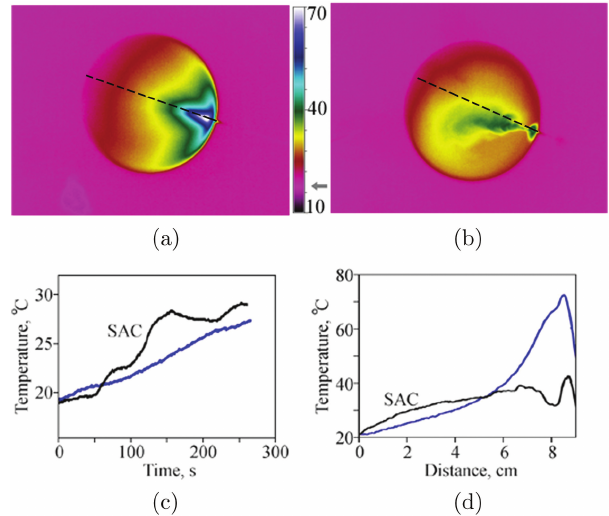
Fig. 4. Processes occurring in a liquid under the action of laser radiation. The temperature distribution on the liquid surface after treatment by laser with a bare ¯ber tip (a) and a SAC ¯ber tip (b) for 2min. The integral temperature in an assign is shown. Dashed line marks axis of the ¯ber. The change of the integral temperature in the assign region (c) and the distribu- tion of the surface temperature along the ¯ber axis (d). Blue line corresponds to laser with a bare ¯ber tip and black line corre- sponds to a SAC ¯ber tip.